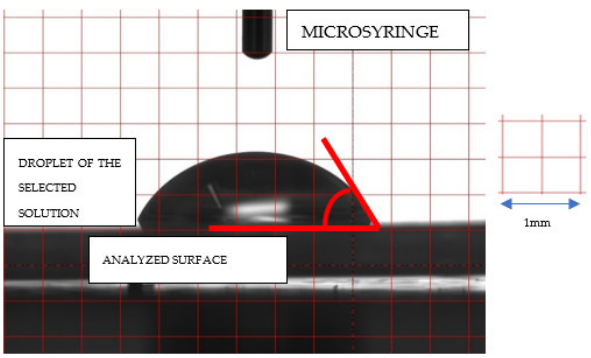
Figure 1. Illustrative image of a droplet on the surface of a sample, taken with a CCD camera.